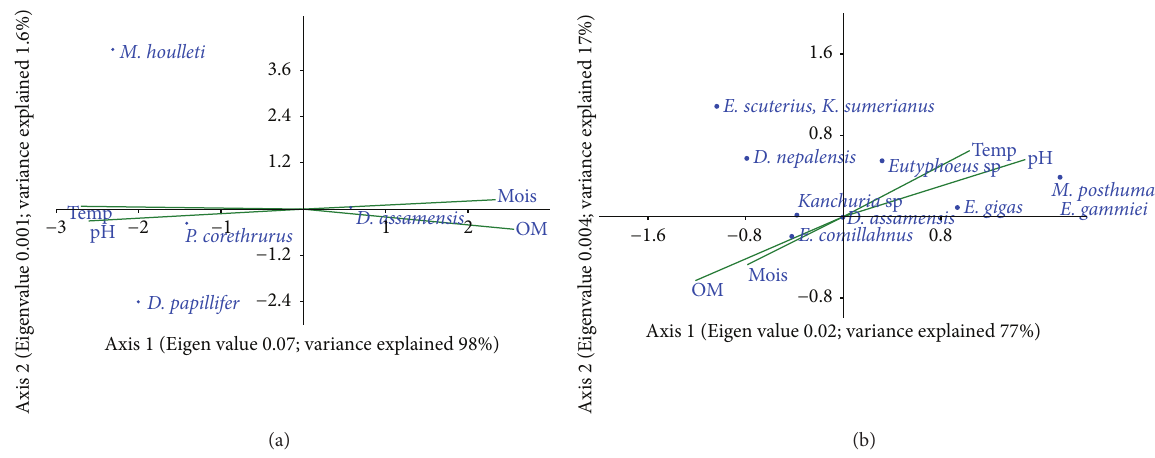
Figure 10: Canonical correspondence analysis (CCA) indicated the relationship between soil physicochemical parameters and (a) common and (b) rare earthworm species of pineapple